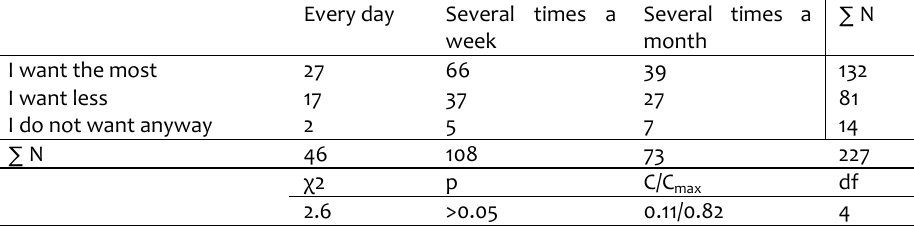
Table 2: Social status of students and physical activity in free time Every day Several times